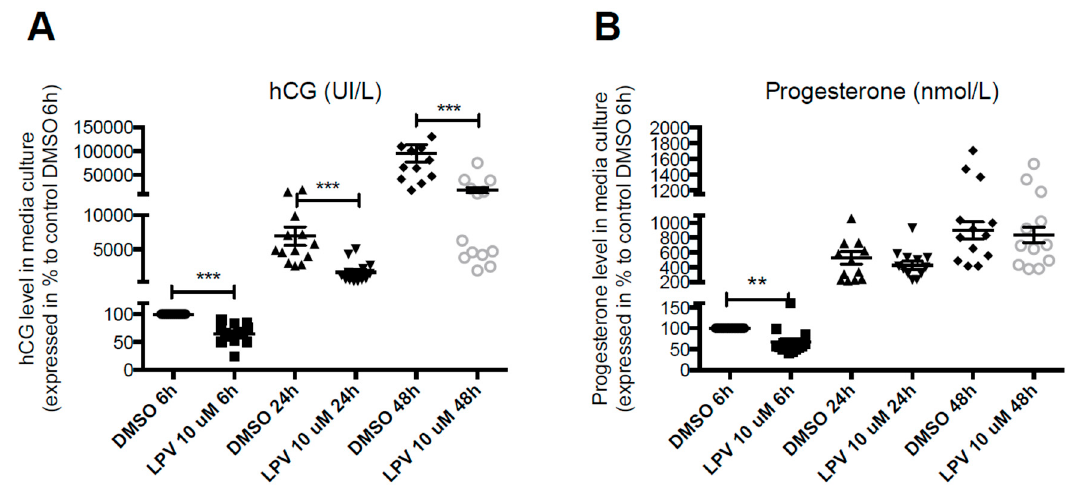
Figure 3. Lopinavir decreases hCG and progesterone secretion during differentiation of VCT into ST. Cytotrophoblasts isolated and purified from term placenta were cultured for 15 h and then incubated with LPV 10 µM or DMSO for 6 h, 24 h or 48 h to allow fusion process. hCG concentrations ( A ) and progesterone concentrations ( B ) were measured by immuno-analysis in culture supernatant. Results are expressed as the mean +/ − SEM of n = 11 independent experiments. ** p < 0.01; *** p < 0.001 vs. DMSO at the same incubation time, two-tailed paired no parametric student t -test.